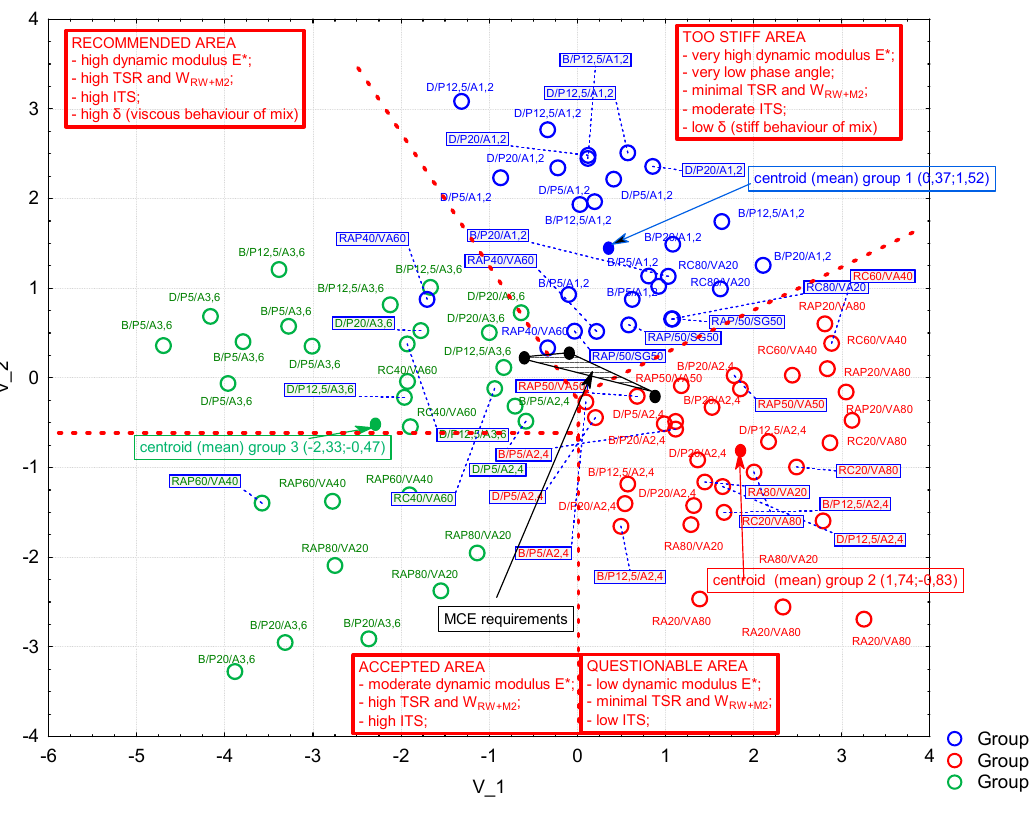
Figure 7. Canonical value scatter plot.